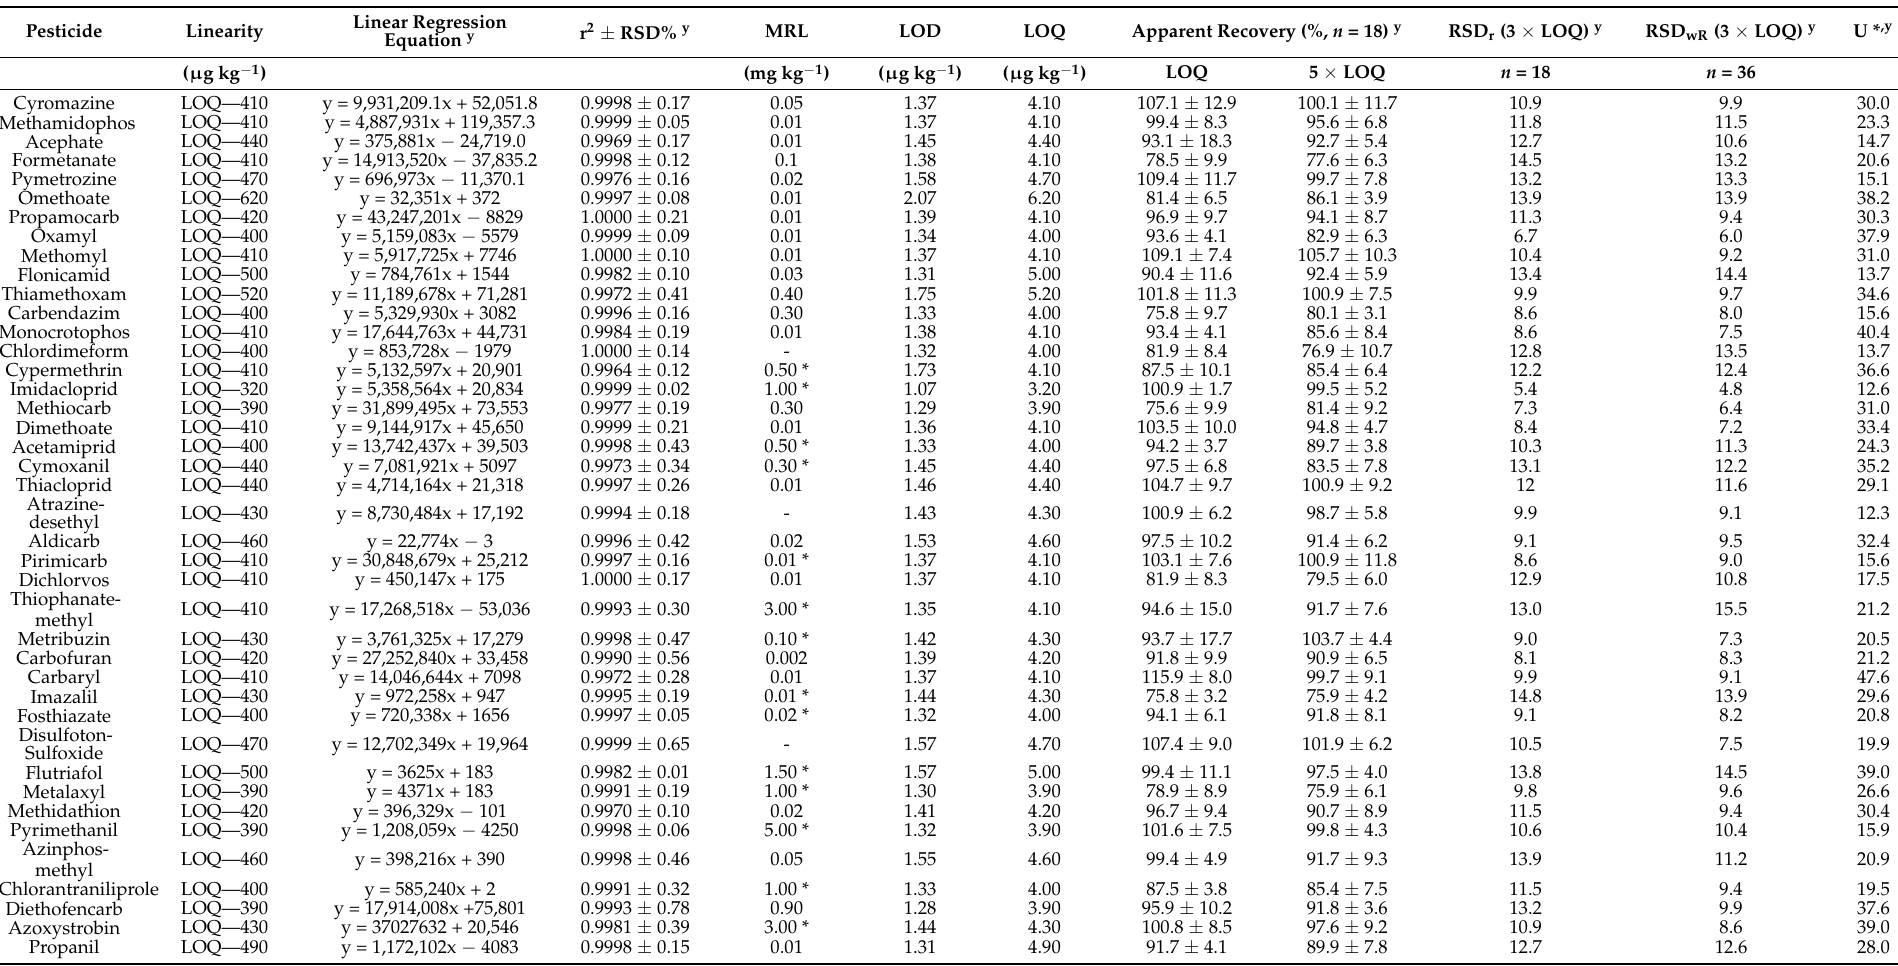
Table 1. Linearities, curves, LODs, and LOQs and method validation parameters for the analysis of 115 target a.i. in grapes juice, must and wine in LC-MS/MS.